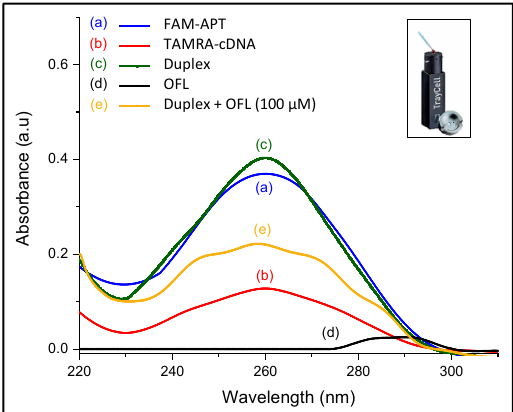
Figure 5. UV characterization of conformation changes in ssDNA sequences (inset: Photo of the Nanodrop cuvette used for the measurements).